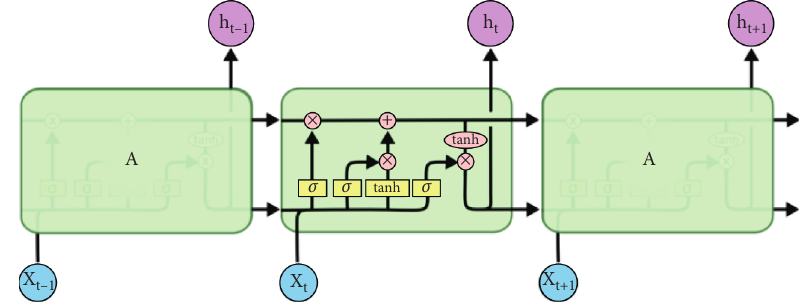
Figure 1: Schematic diagram of the LSTM cell structure